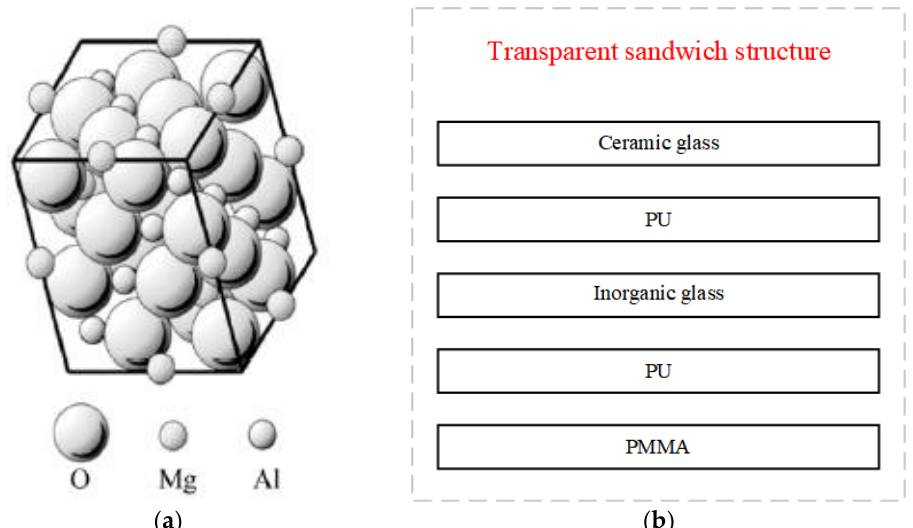
Figure 1. ( a ) Microscopic diagram of magnesium–aluminum spinel; ( b ) A new type of transparent sandwich structure.